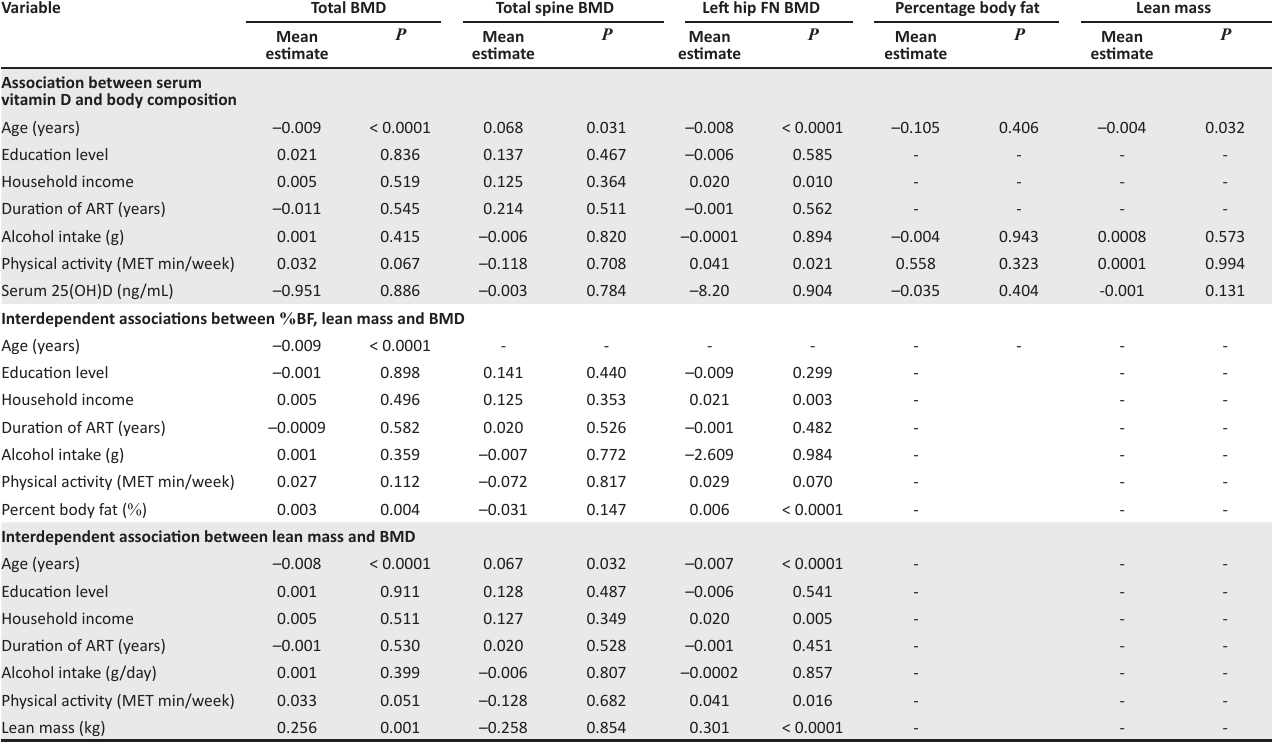
TABLE 4: Association between serum vitamin D and body composition and interdependent associations between body composition variables. Variable